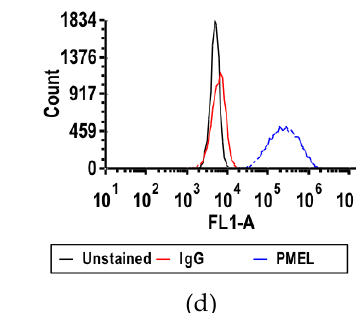
( b ) Figure 4. Secretion of PEDF by RPE cells at passage 3 on day 30: ( a ) no significant difference between concentration of PEDF in the apical chamber or basal chamber when comparing diseased and 1